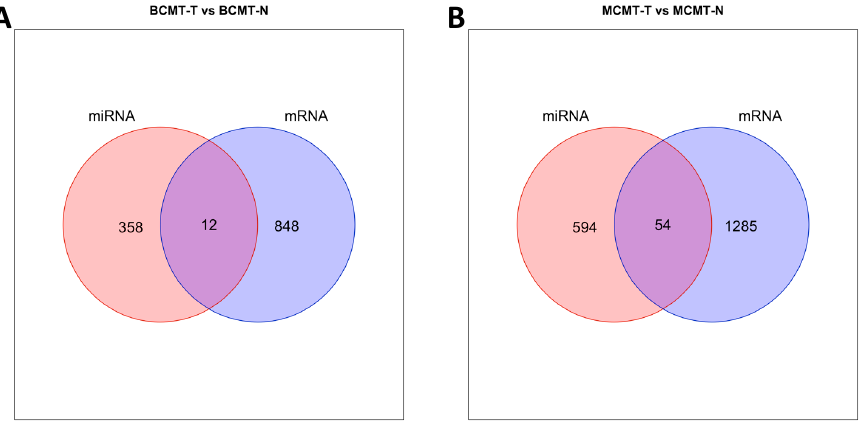
Figure 6. Venn diagram of commonly appearing genes between miRNAs and their targeted mRNAs. ( A ) BCMT-T vs. BCMT-N; ( B ) MCMT-T vs. MCMT-N.